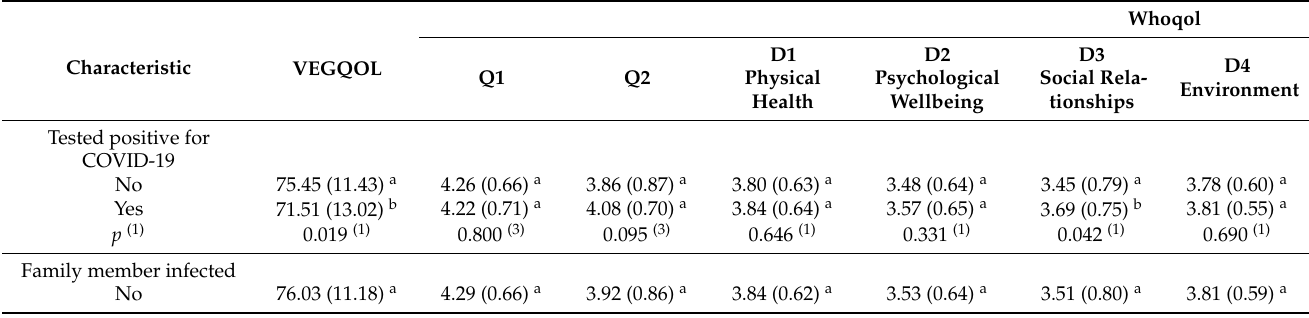
Table 2. Mean and standard deviation from VEGQOL and WHOQOL-BREF results, according to sociodemographic characteristics ( n =